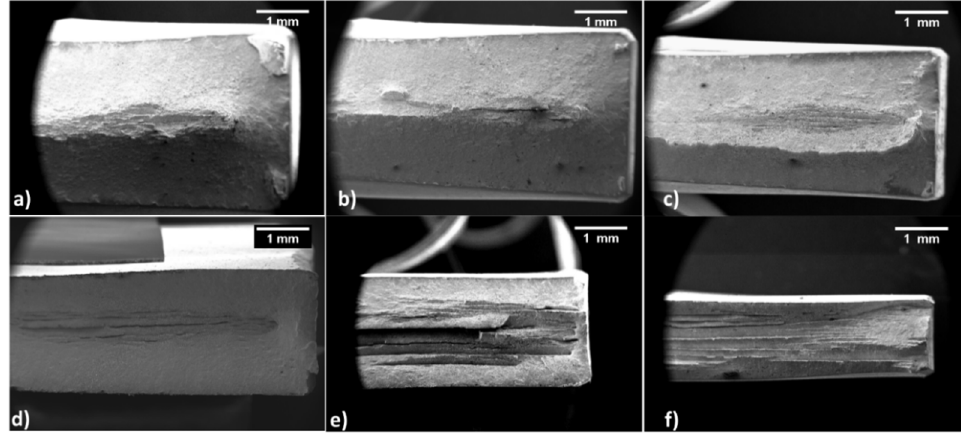
Figure 12. Fractured surface of longitudinal samples with increasing work hardening levels of ( a ) 20%, ( b ) 30%, ( c ) 40, ( d ) 50%, ( e ) 60% and ( f ) 70%.